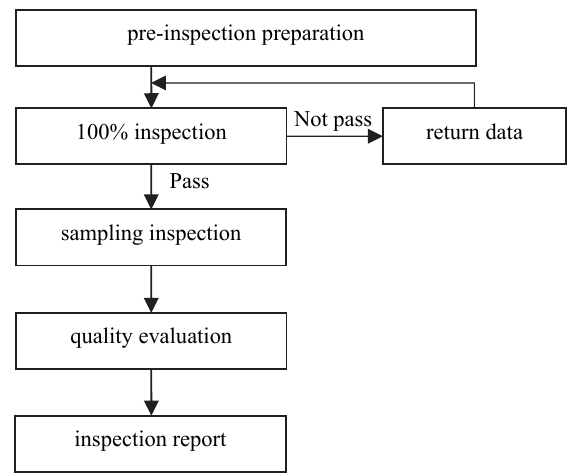
Figure 1. Quality Inspection